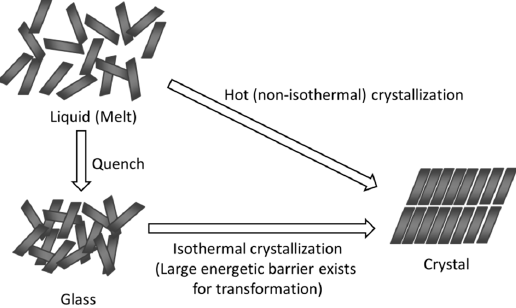
Figure 1. Schematic representation of hot (non-isothermal) and isothermal